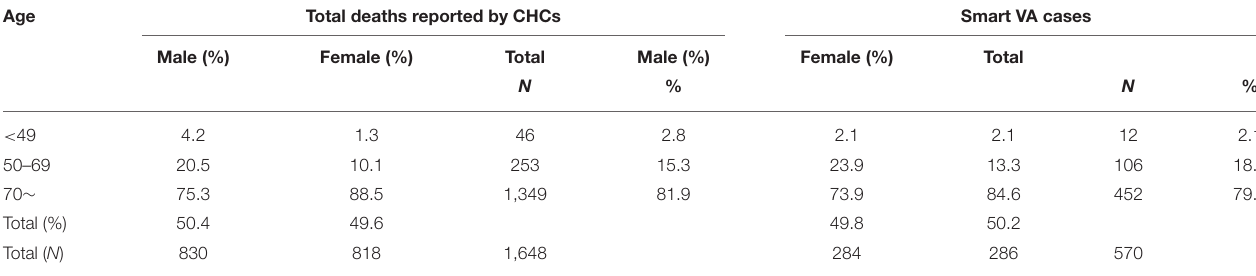
TABLE 1 | Age-sex distribution of home deaths and deaths investigated by Smart Verbal Autopsy (SmartVA) in the 16 community health centers (CHCs). Age Total deaths reported by CHCs Smart VA cases